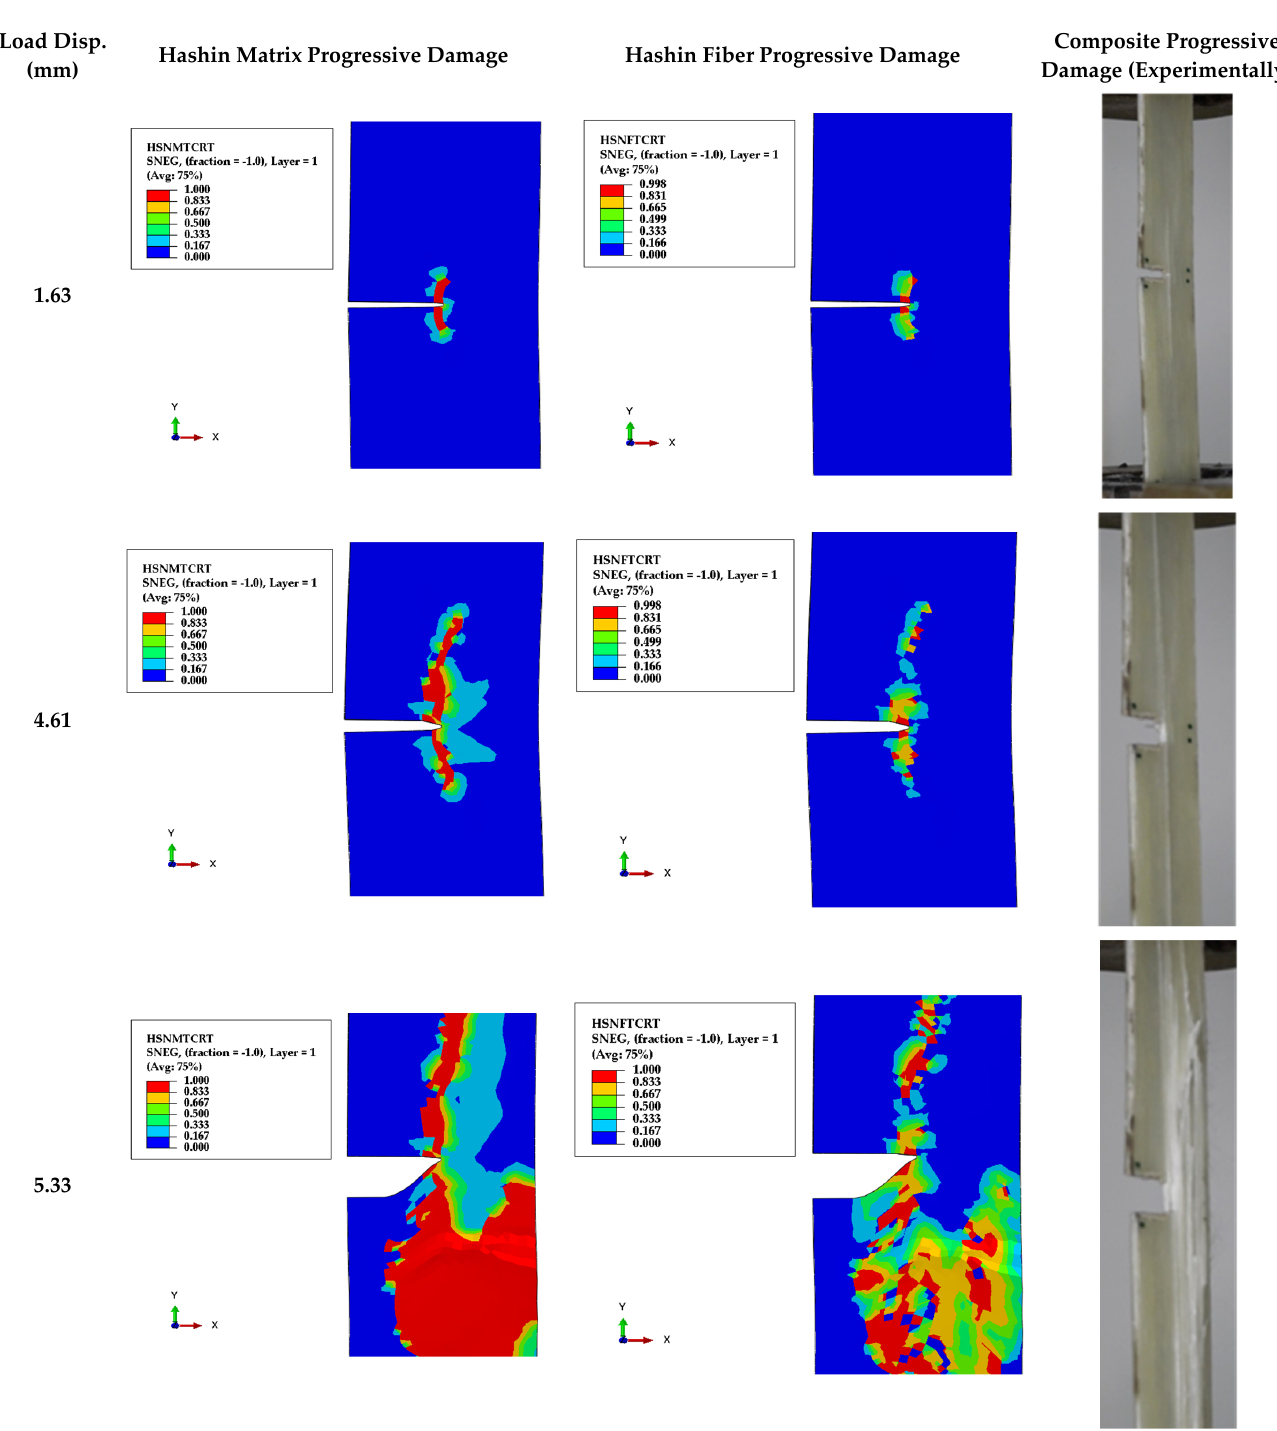
Figure 10. Numerical and experimental progressive damage failure of TTC ASTM D3039 specimen.